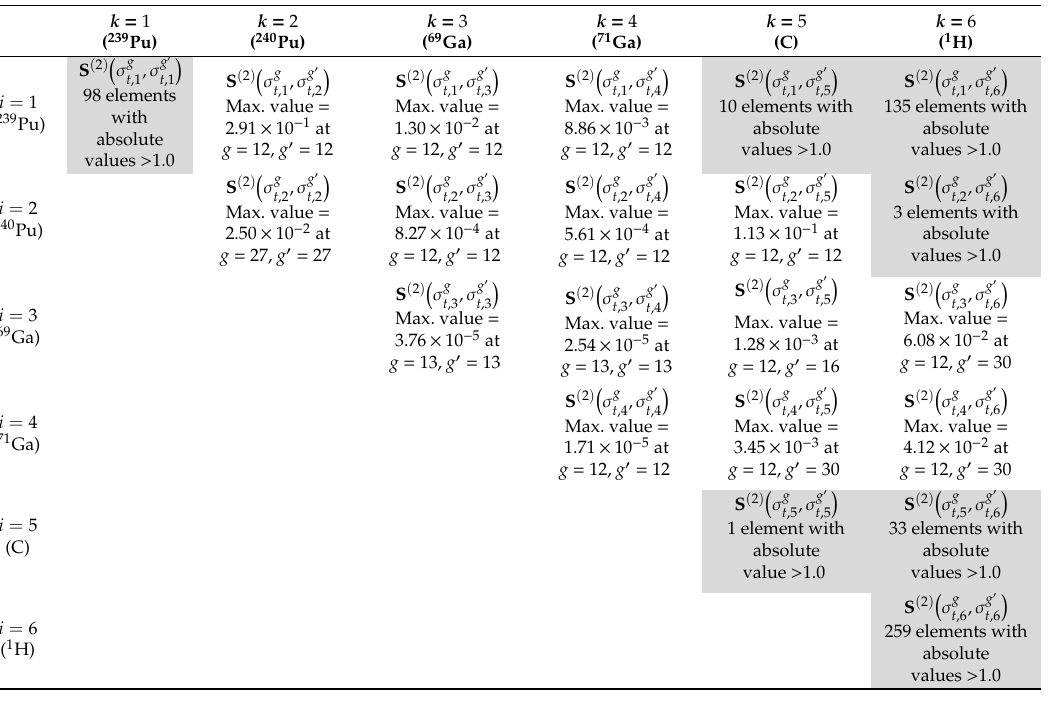
(cid:16) (cid:17) (cid:48) σ g , σ g t , i t , k